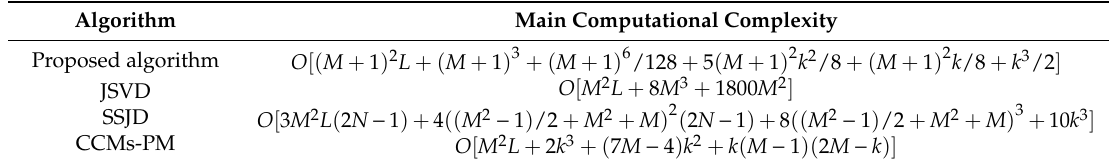
Table 1. Comparison of the computational complexity for di ff erent algorithms.